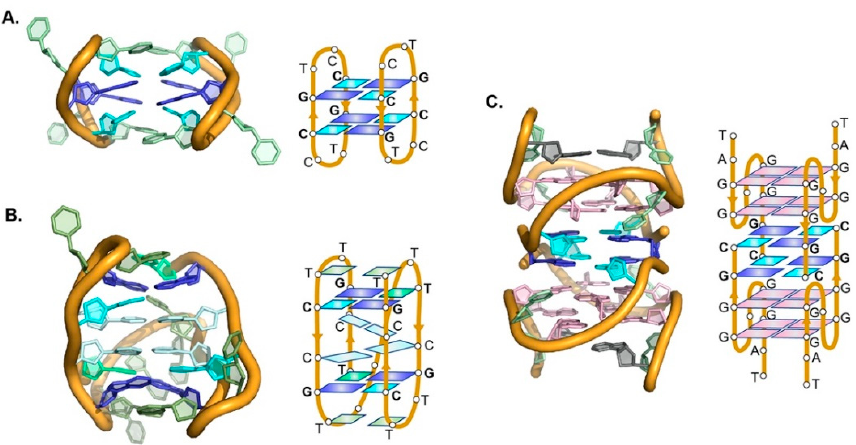
Figure 5. Examples of structures containing non-G tetrads. ( A ) Dimeric structures formed by two cyclic oligonucleotides <dCCGTCCGT> stabilized by two minor groove C:G:C:G tetrads (PDB 2HK4). ( B ) Minimal i-motif structure stabilized by two C:C + base pairs capped by two minor